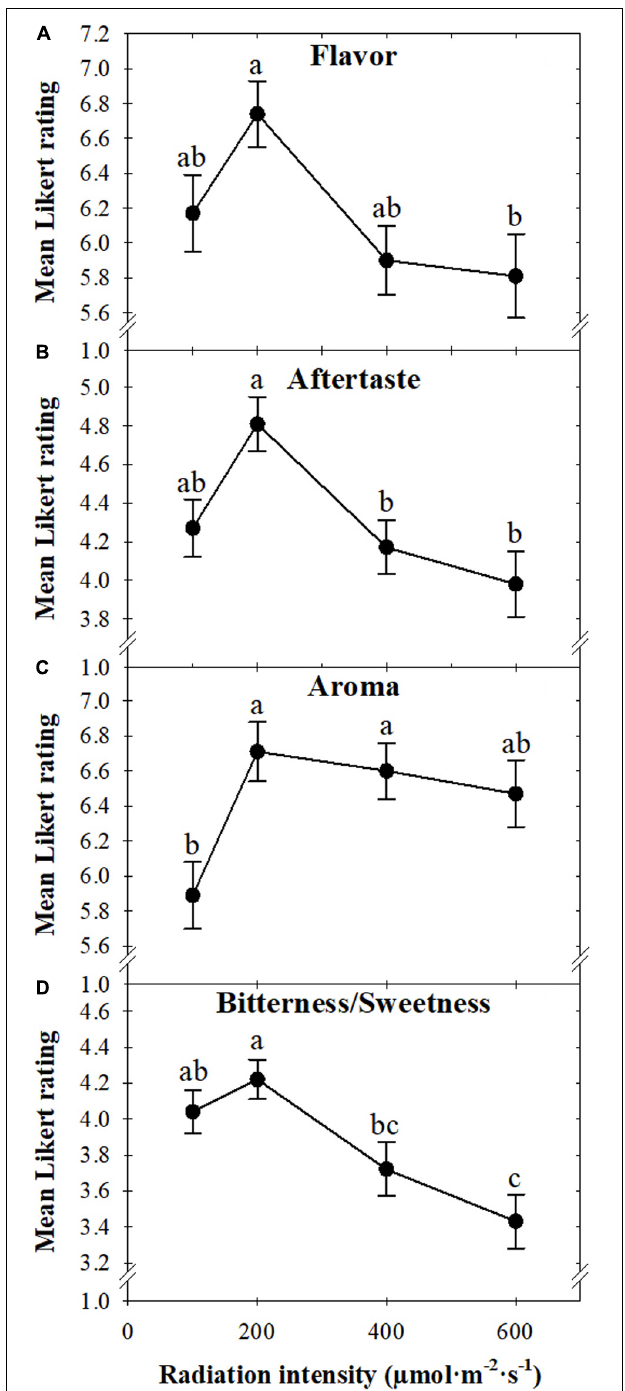
FIGURE 4 | Mean flavor (A) , aftertaste (B) , and aroma (C) of sweet basil “Nufar” ( Ocimum basilicum ) grown under 100, 200, 400, or 600 µ mol · m − 2 · s − 1 photosynthetic photon flux density (PPFD), based on a nine-point Likert scale ranging from dislike extremely (1) to like extremely (9) and the bitterness/sweetness (D) based on a nine-point Likert scale ranging from extremely bitter (1) to extremely sweet (9). Means not followed by the same letter are significantly different by Tukey honestly significant difference test ( P < 0.05). Each symbol represents 90 responses ±